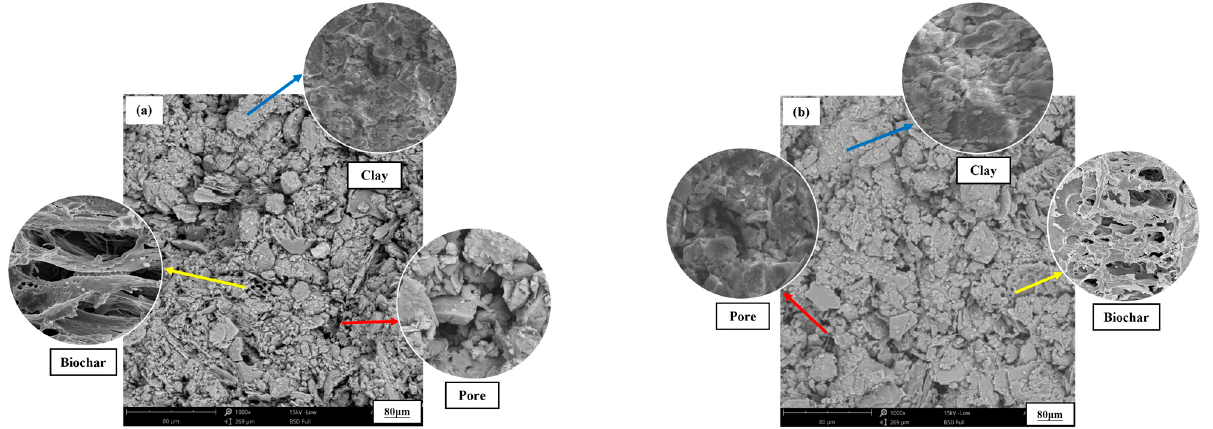
Figure 14. SEM images of the biochar–clay mixture under different dry densities: ( a ) ρ d = 1.48 g/cm 3 ; ( b ) ρ d = 1.64 g/cm 3 .